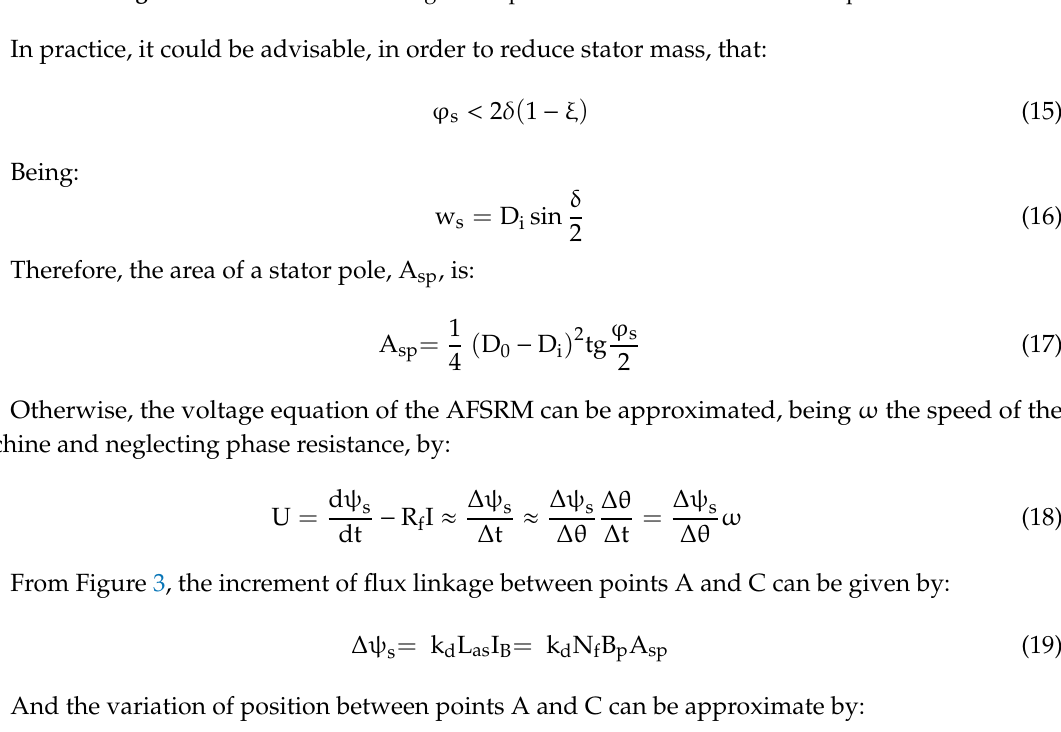
Figure 5. Stator section showing the disposition and dimensions of stator poles.